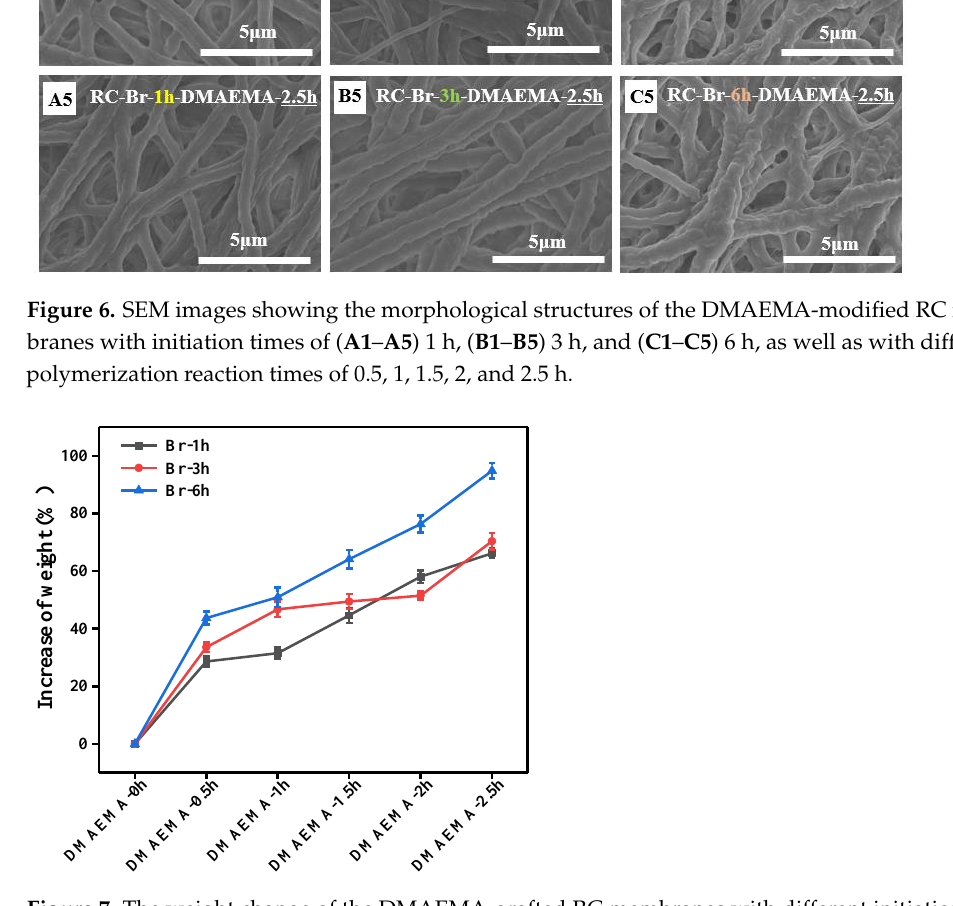
Figure 7. The weight change of the DMAEMA-grafted RC membranes with different initiation and grafting times.